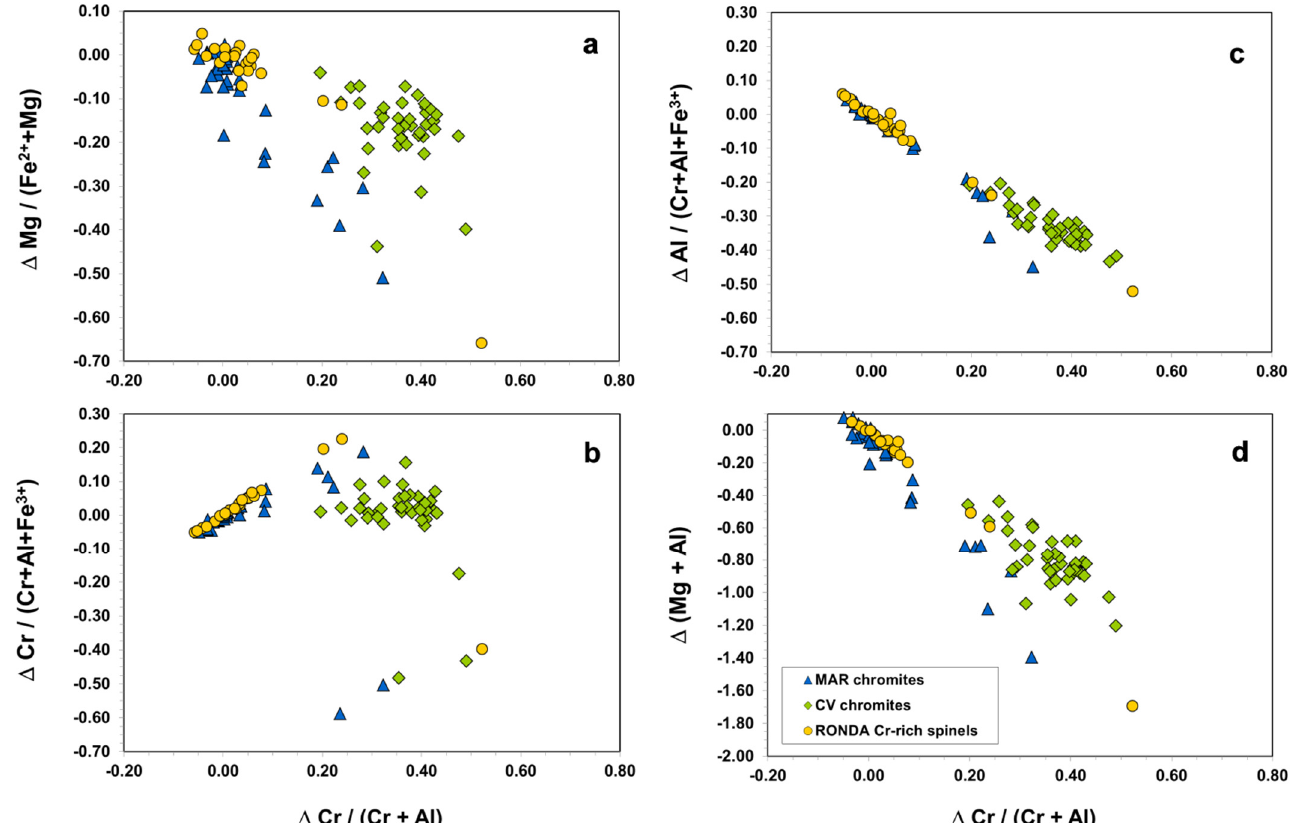
Figure 11. Variation of ( a ) Mg/(Fe 2+ + Mg), ( b ) Cr/(Cr + Al + Fe 3+ ), ( c ) Al/(Cr + Al + Fe 3+ ) and ( d ) (Mg + Al) with increasing Cr/(Cr + Al) ratios in the MAR magnesiochromites, CV chromites and Ronda chromian spinels.